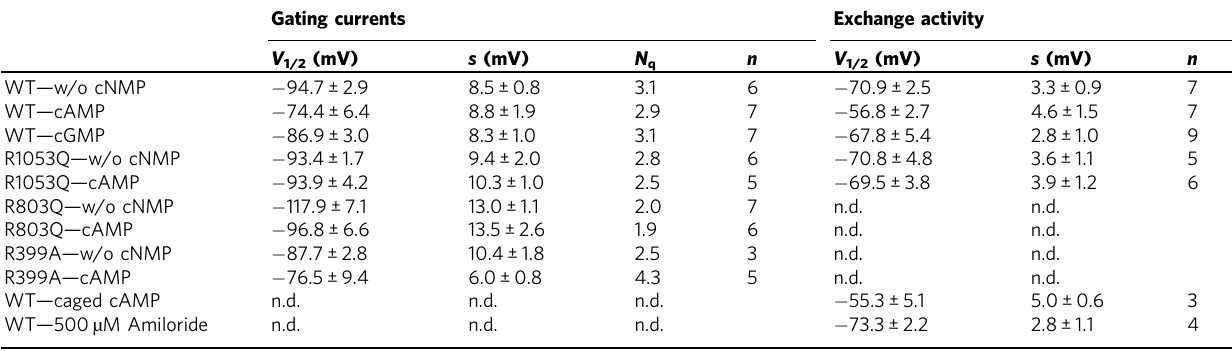
Table 1 Summary of activation properties of Sp SLC9C1 from gating currents and voltage-clamp fl